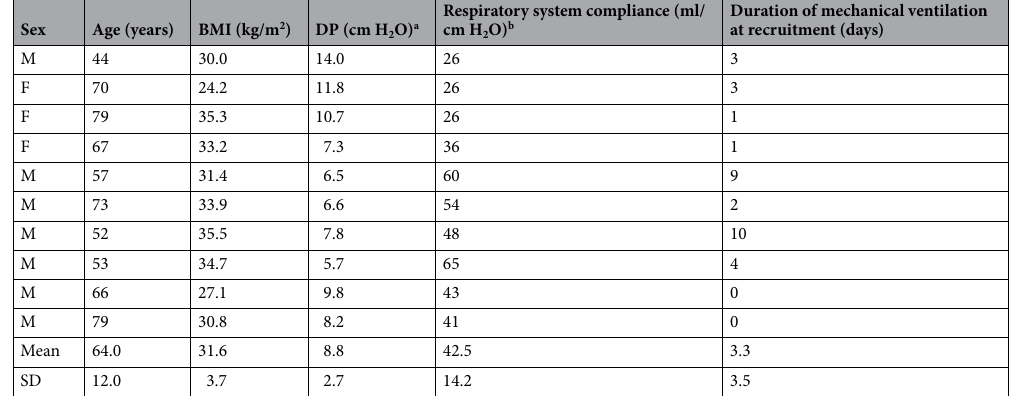
Table 1. Patients’ characteristics. BMI body mass index, DP driving pressure. a At PEEP of 12 cm H 2 O in supine position. b At PEEP of 12 cm H 2 O in supine position.